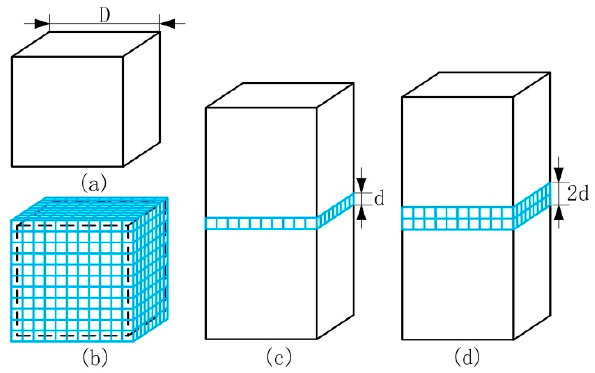
Figure 6. The relative position of reinforcing particles and matrix particles: ( a ) a matrix alloy particle, ( b ) the distribution of reinforcing particles, ( c ) the homogeneous distribution, and ( d ) the saturated distribution.